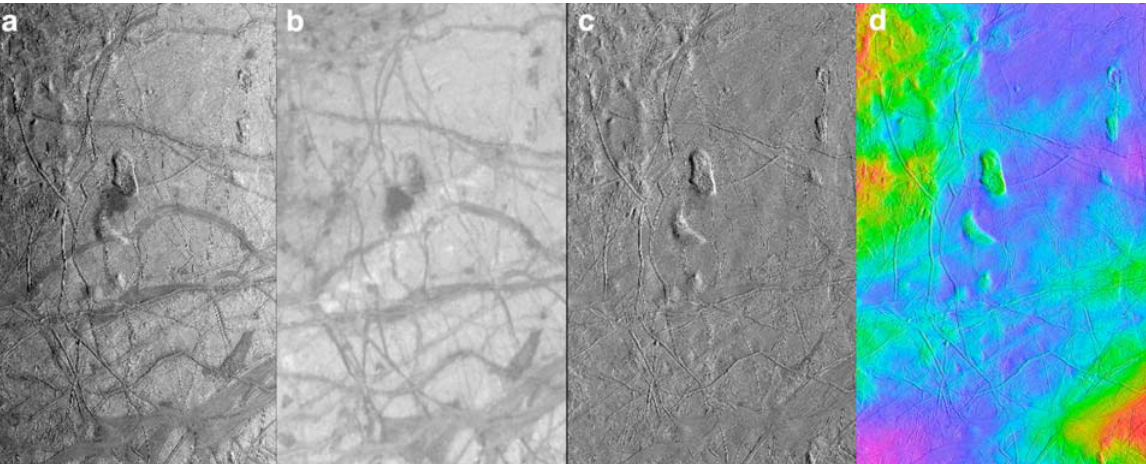
Figure 1. Input data for Europa stereo simulations. (a) Mosaic of 6 Galileo SSI frames with ~80° incidence angle, 210 m GSD. (b) Coregistered single frame with 21° incidence, 1570 m GSD serves as an albedo map of the region after appropriate scaling. (c) Ratio of a to b is effectively albedo corrected. (d) DTM generated from c by two-dimensional photoclinometry [7] shown as color-coded elevations overlaid on c. Range of elevations from purple (low) to red (high) is 3200 m. All images are 294x472.5 km, Equirectangular projection centered at 0.7°N, 225.3°W (134.7°E), north at